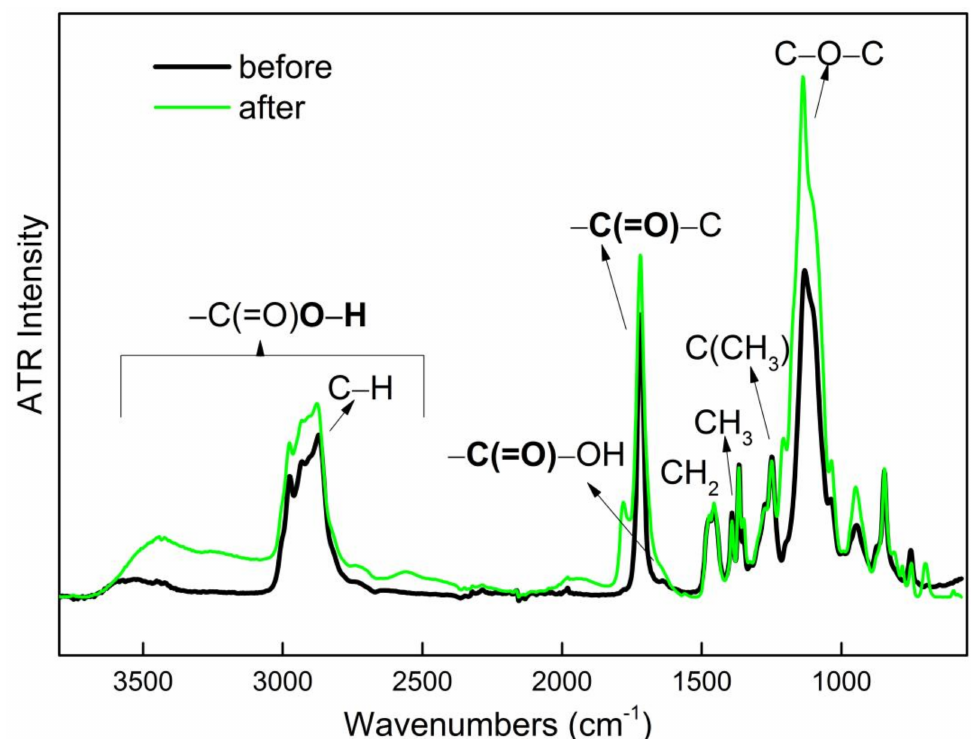
Figure 3. FT-IR spectra of HC 2 before and after